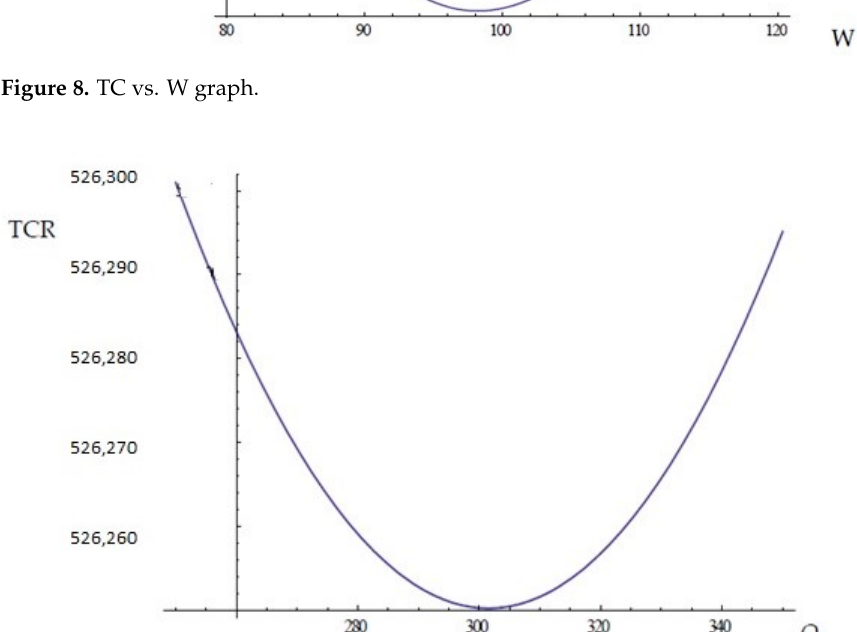
Figure 8. TC vs. W graph.